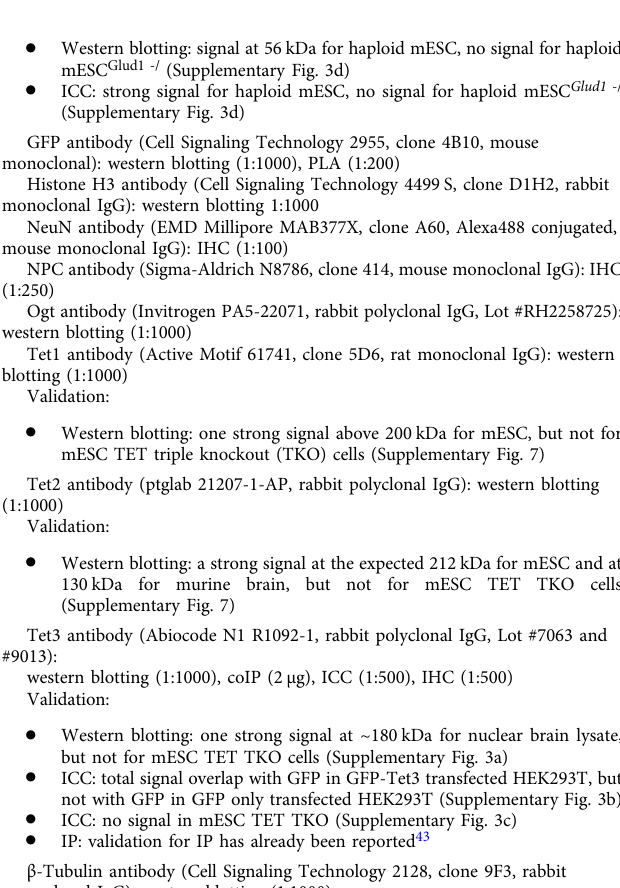
Methods All procedures concerning animals conform to the German animal protection laws and were approved by the local authority (Regierung von Oberbayern). Antibodies . CoxIV antibody (Cell Signaling Technology brain-derived neuro- trophic fact4850, clone 3E11, rabbit monoclonal IgG): western blotting (1:1000), ICC (1:500) Cytochrome C antibody (Santa Cruz Biotechnology sc-13560, clone 7H8, mouse monoclonal IgG): western blotting (1:1000) FLAG antibody (Sigma-Aldrich F1804, clone M2, mouse monoclonal IgG): western blotting (1:2000), ICC (1:500) FLAG antibody (Sigma-Aldrich F2555, clone SIG1-25, rabbit monoclonal IgG): PLA (1:250) Gdh antibody (Invitrogen PA5-19267, goat polyclonal IgG, Lot #74422112, P1): western blotting (1:1000 – 1:2000), ICC (1:100 – 1:200), IHC (1:100) Validation: